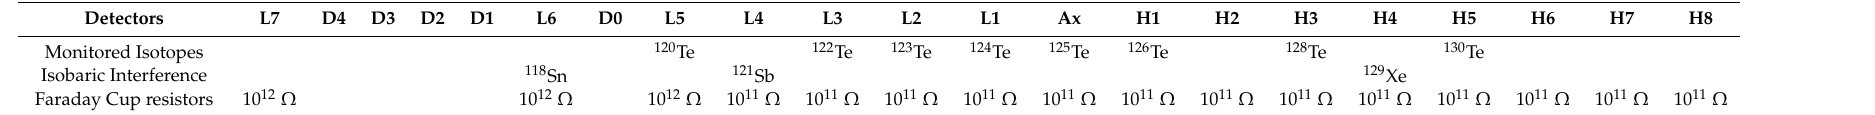
Table 5. Configuration of collectors in